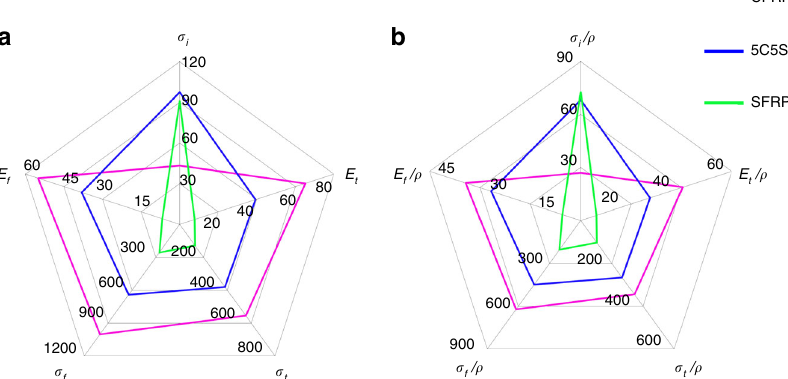
Fig. 7 Comparative radar plots of the key mechanical properties. a Impact strength σ i (kJm − 2 ), tensile modulus E t (GPa), tensile strength σ t (MPa), fl exural modulus E f (GPa), fl exural strength σ f (MPa). b Speci fi c impact strength 10 3 σ i / ρ (kJ m − 2 (kg m − 3 ) − 1 ), speci fi c tensile modulus 10 3 E t / ρ (GPa (kgm − 3 ) − 1 ),